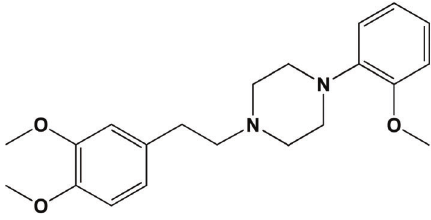
Figure 1. 2-D structure of LDT5 in its base